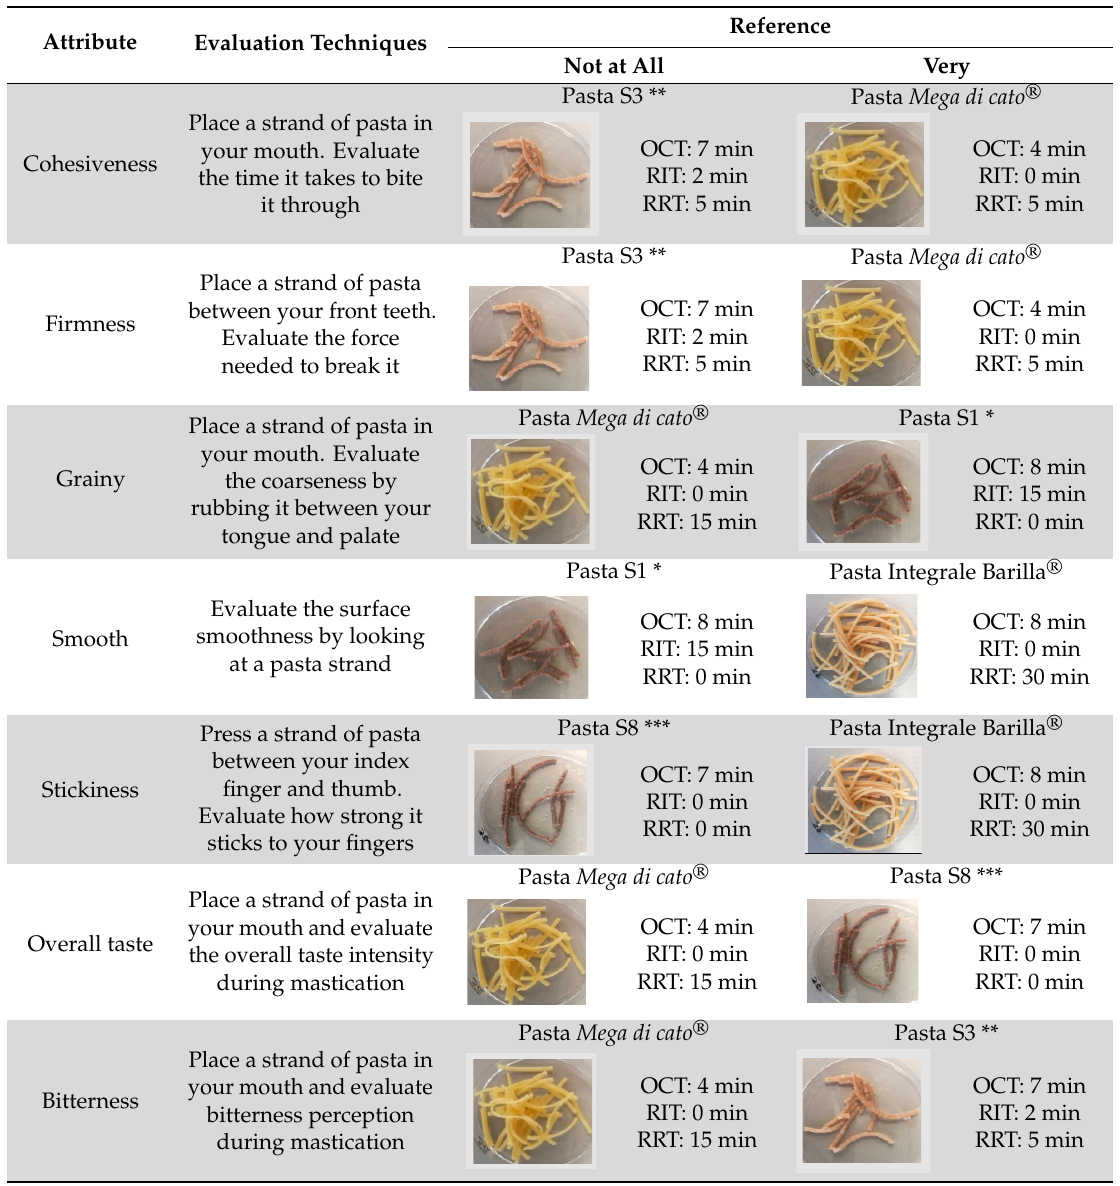
Table 3. Attributes, evaluation techniques, and references used for sensory profiling of buckwheat- based pasta.